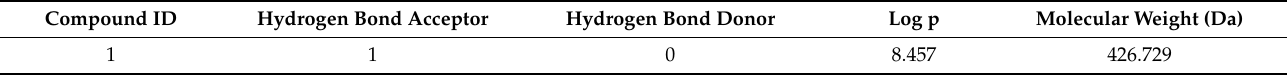
Table 6. Pharmacokinetic (ADMET) properties.